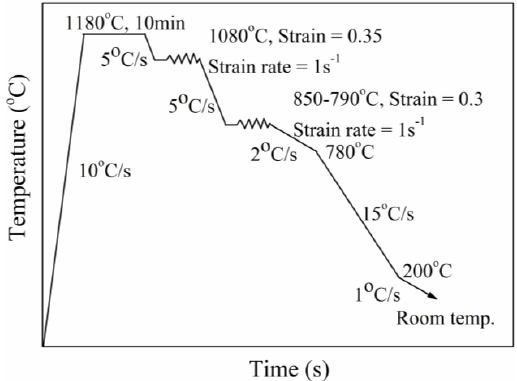
Figure 1. Graph of the simulated TMCP (thermo mechanical control process) on the Gleeble for the steel with different finish rolling temperatures.